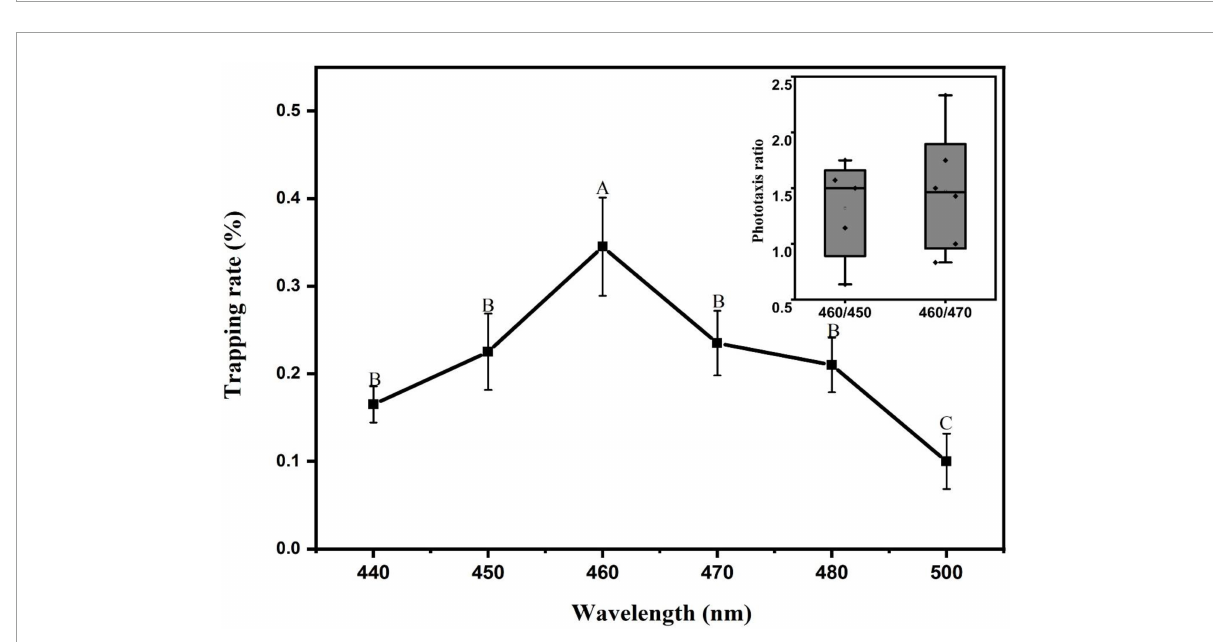
FIGURE8 Trapping rate of L. striatellus at different monochromatic light in the range 440-500 nm. Each value represents the trapping rate T 1 of adult L. striatellus for the specific wavelength of the light source, and the error bars represent the standard error. Different letters above each group of data indicate significant differences between treatments ( p < 0.01). The upper right panel shows the trapping rate T2 of 460 nm vs. 470 nm and 460 nm vs. 450